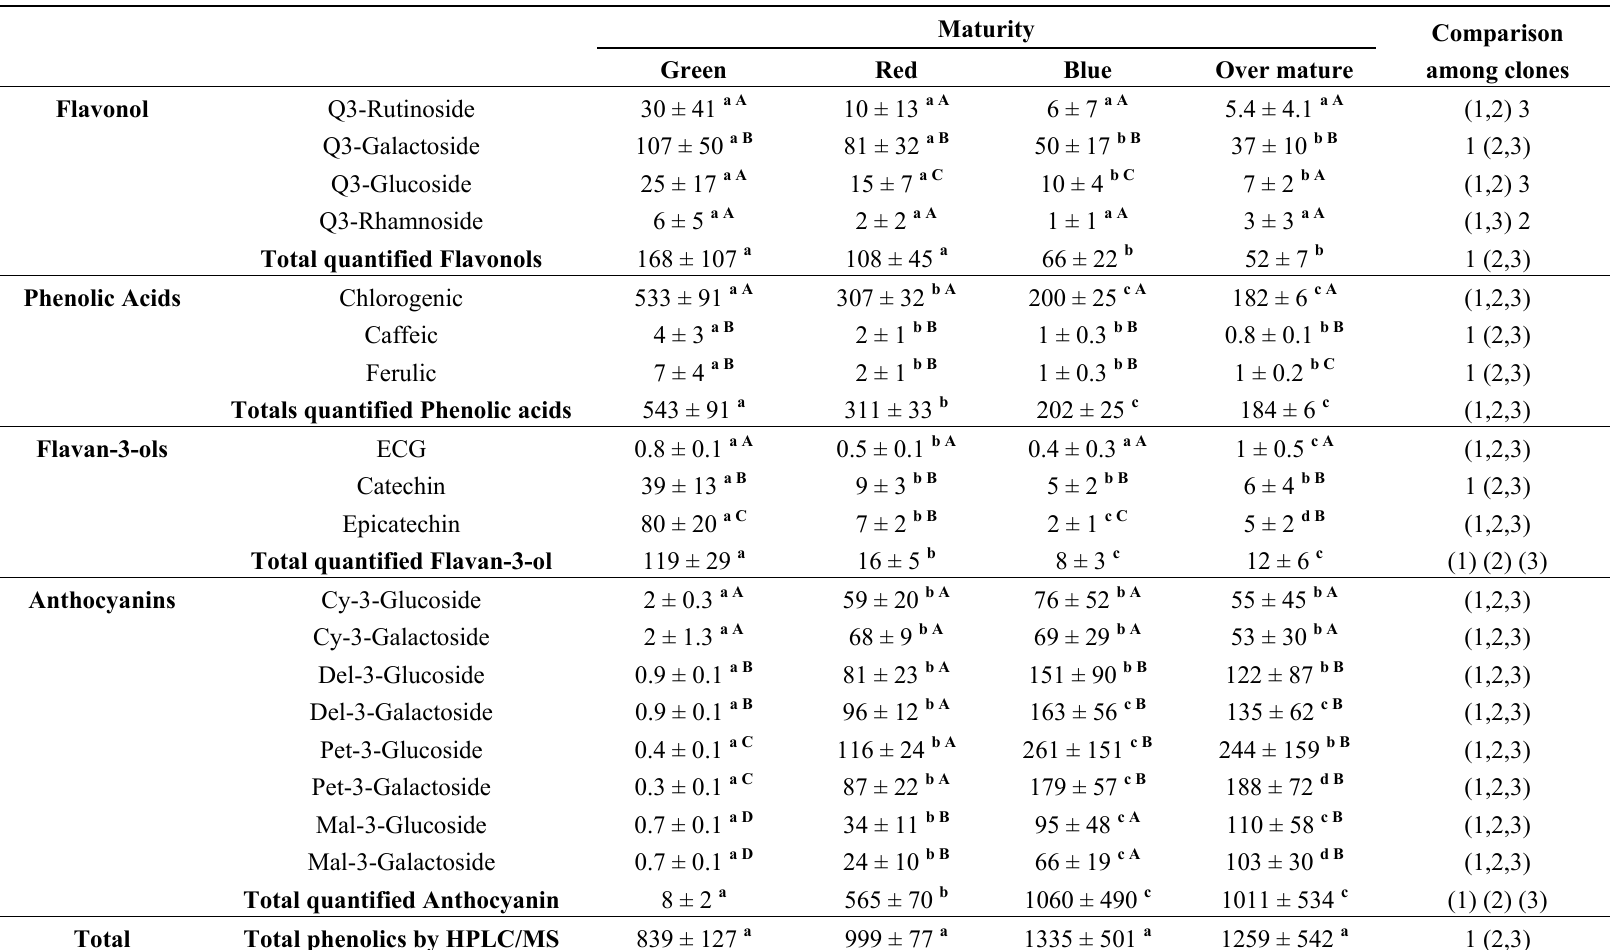
Table 1. The major polyphenols (mg/100 g DW) found in lowbush blueberries at four